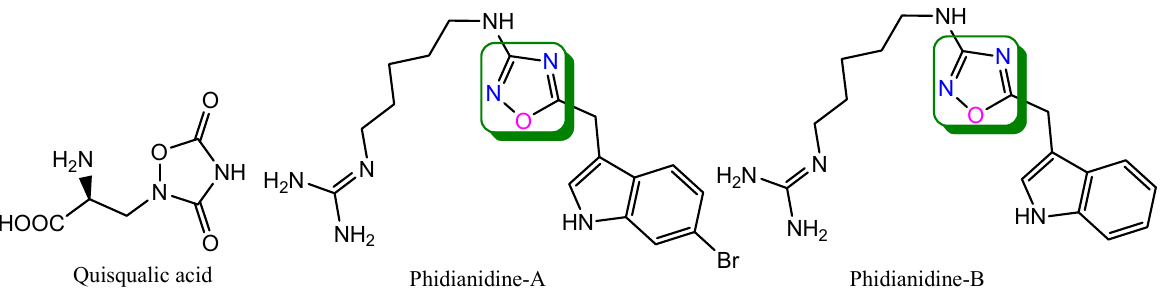
Figure 4. Structures of naturally occurring compounds containing 1,2,4-oxadiazole ring. Tiodazosin is a new antihypertensive drug, structurally resembles prazosin. It pos- sesses alpha-adrenergic-blocking activity and exerts a direct vasodilation effect. Chemically, it is (4-(4-amino-6,7-dimethoxyquinolin-2-yl)piperazin-1-yl)(5-(methylthio)-1,3,4-oxadiazol- 2-yl)-methanone [28]. Furamizole is a nitrofuran derivative and possesses antibacterial activity. Chemically, it is (E)-5-(1-(furan-2-yl)-2-(5-nitrofuran-2-yl)vinyl)-1,3,4-oxadiazol- 2-amine.Raltegravir (MK-0518) is an antiretroviral drug produced by Merck and Co., Kenilworth, NJ, USA. It was approved by the U.S. Food and Drug Administration (USFDA) in October 2007. It is the new class of anti-HIV drug and acts as an integrase